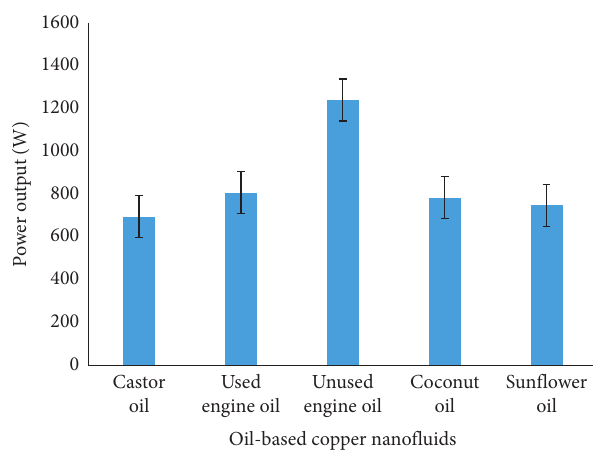
Figure 3: Maximum power output for oil-based copper nano-heat transfer